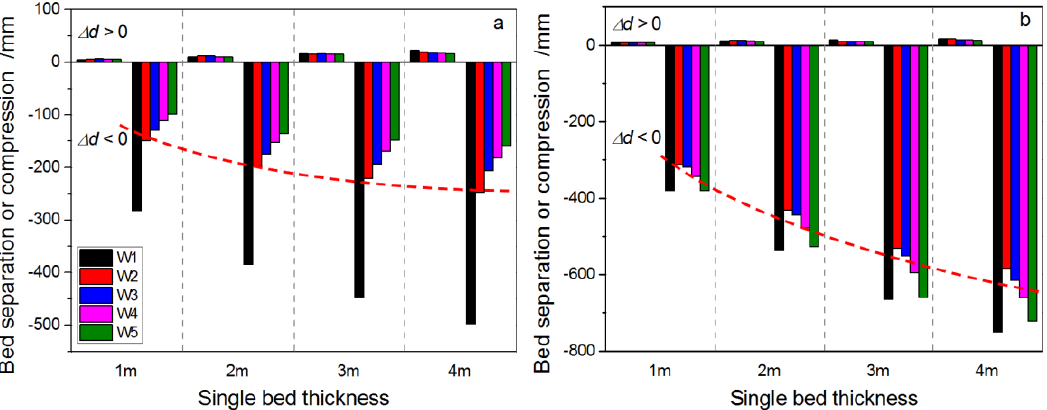
Figure 6. Extreme value statistics of bed separation and compression along various well trajectories after the ( a ) first panel is removed and then ( b ) the second panel is removed for various SMHs.